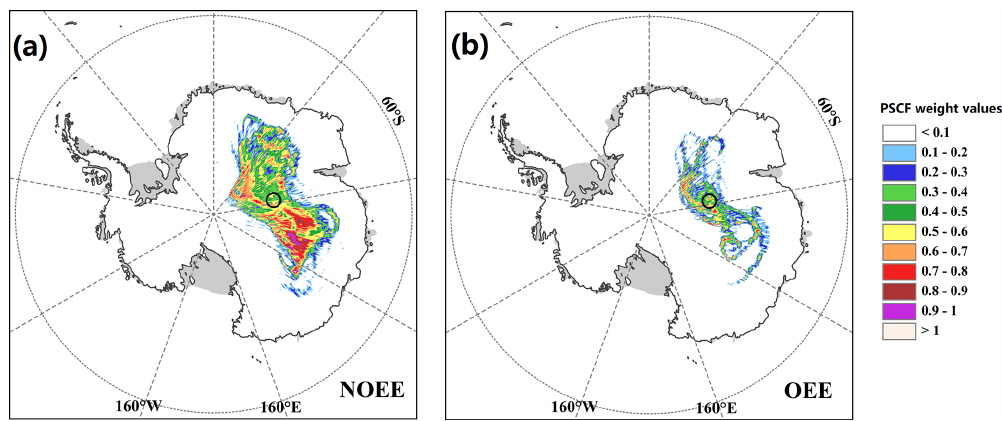
Figure 7. Likely source areas of surface O 3 at Kunlun Station during the NOEE (a) and OEE (b) identified using the PSCF (potential source contribution